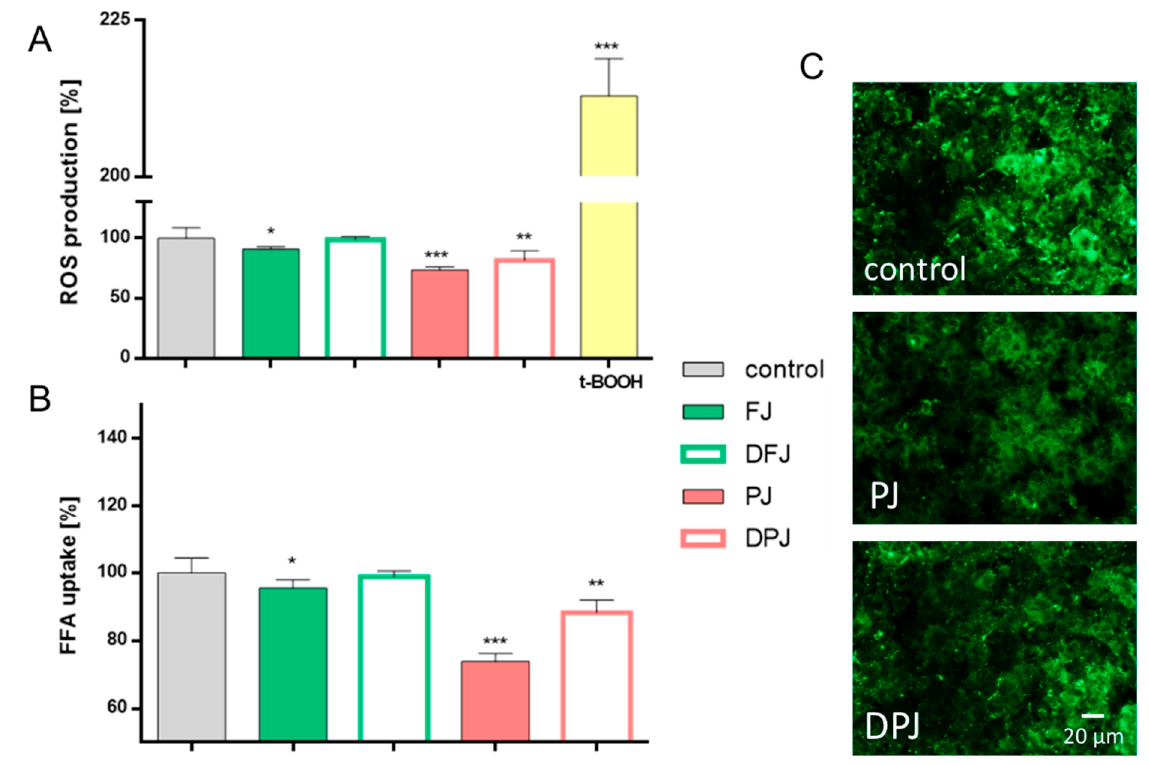
Figure 2. The effect of V. opulus juice samples on intracellular ROS generation ( A ) and on fatty acid analogue TF2-C12 uptake ( B ) in HepG2 cells after 24 h incubation with fresh juice (FJ), digested fresh juice (DFJ), purified juice (PJ), and digested purified juice (DPJ); for positive control for ROS generation, 500 µM tert -BOOH was used; values are means ± standard deviations from at least five independent experiments, n ≥ 9; statistical significance was calculated versus control cells (untreated), * p ≤ 0.05, ** p ≤ 0.01, *** p ≤ 0.001. Cellular uptake of TF2-C12 analogue visualized under a fluorescent microscope (200× magnification) ( C ).